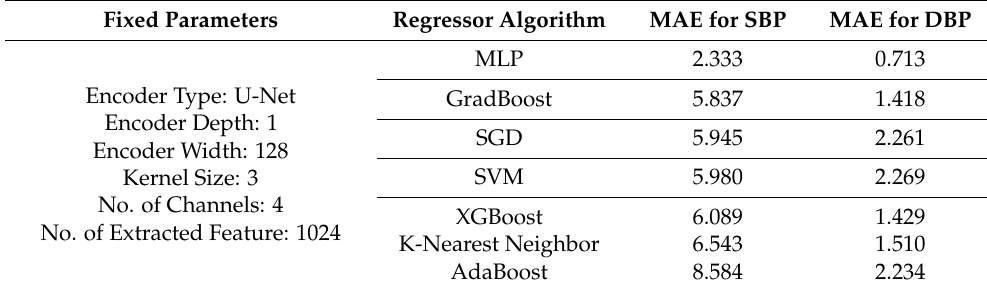
Table 8. MAE of systolic blood pressure (SBP) and diastolic blood pressure (DBP) for different machine learning (ML) techniques in Experiment 1.